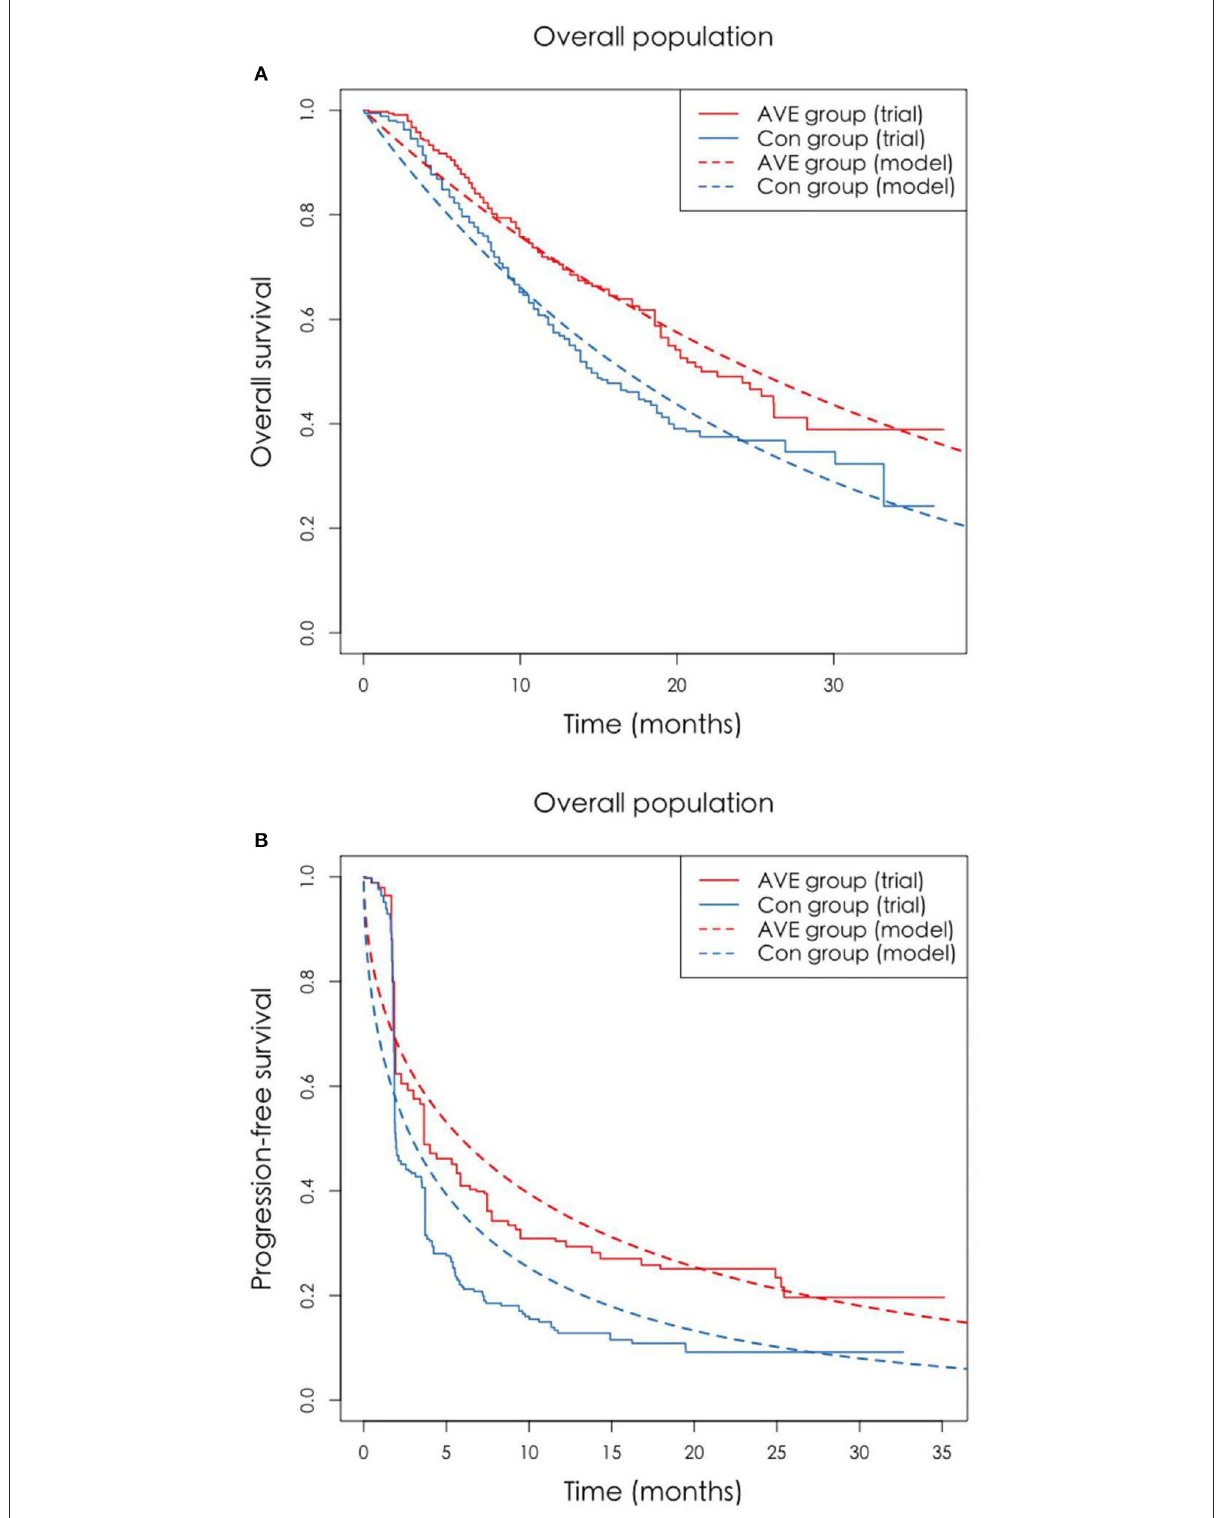
FIGURE2 (A,B) The original Kaplan-Meier PFS and OS curves from the trial and fitted curves (Weibull distributions). OS, overall survival; PFS, progression-free